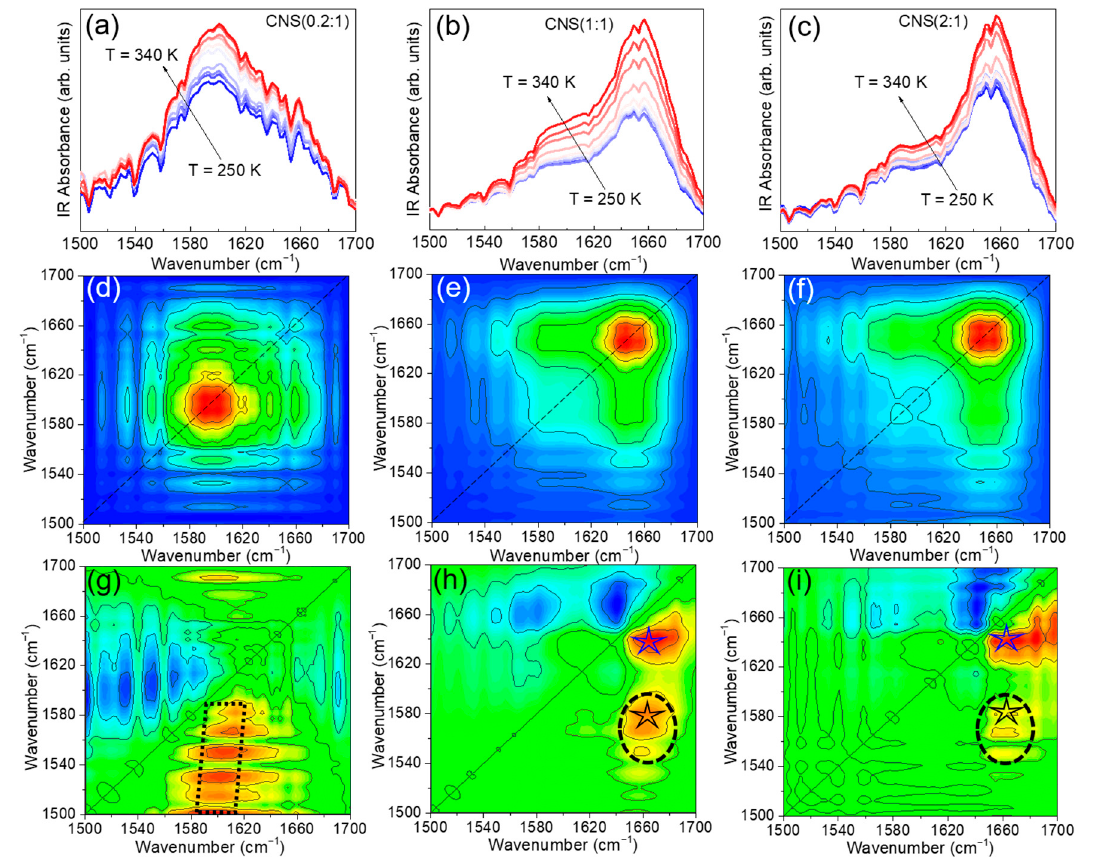
Figure 5. Temperature-dependent FTIR-ATR spectra ( a – c ) of the investigated samples in the 1500–1700 cm − 1 wavenumber range; corresponding SCMs and ACMs for CNS (0.2:1) (( d ) and ( g ), respectively), CNS (1:1) (( e ) and ( h ), respectively) and CNS (2:1) (( f ) and ( i ), respectively). In the case of SCMs, red-colored regions define positive correlation intensity ( Θ ( v 1 , v 2 ) > 0), whereas blue-colored areas account for a Θ ( v 1 , v 2 ) ~ 0 condition. Conversely, in ACMs, red, green and blue-colored areas describe positive, null and negative correlation intensities, respectively. The black and blue stars in panels ( h , i ) show CPs located at ~(1654,1583) cm − 1 and ~(1654,1635) cm − 1 . Dotted (in ( g )) and dashed (in ( h , i )) lines highlight regions of interest for our discussion. See text for details.